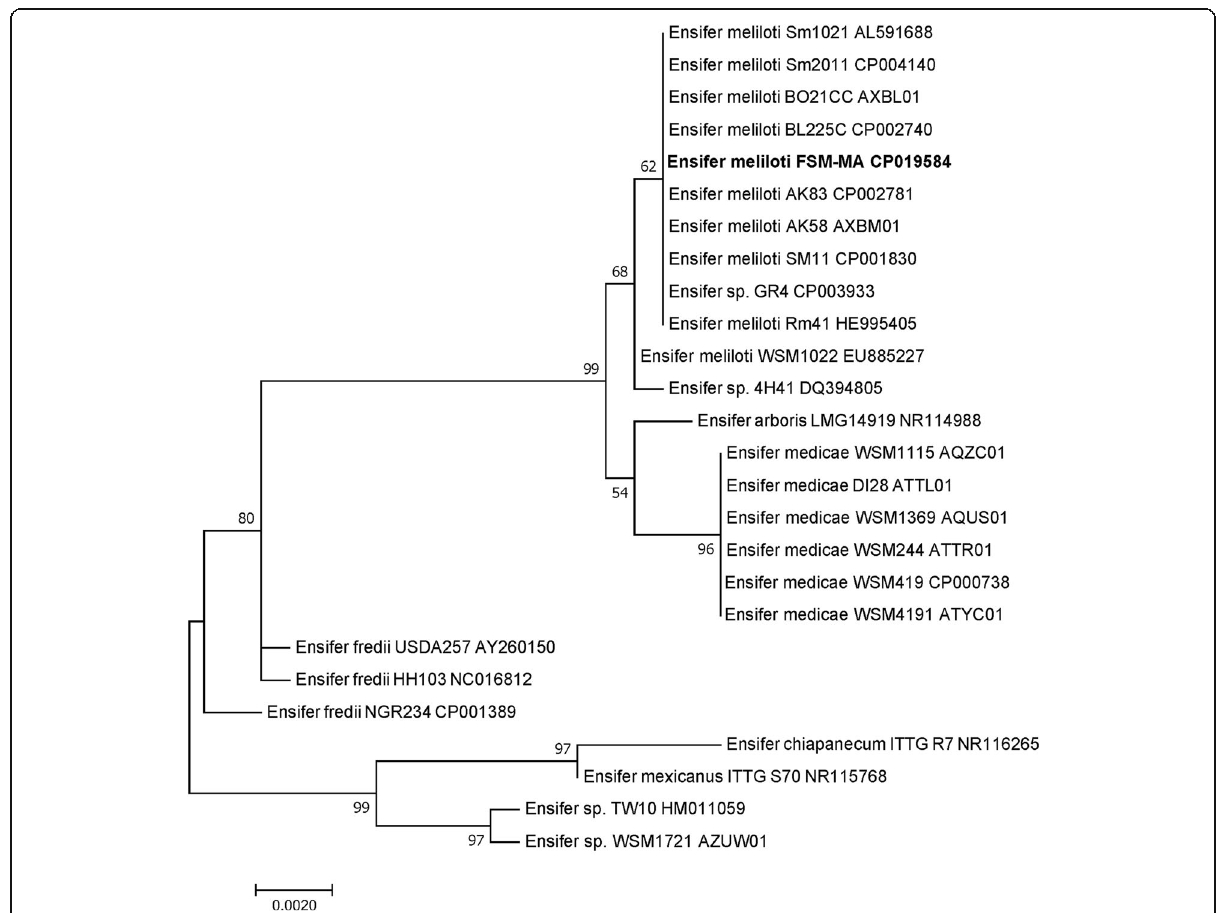
Fig. 2 Phylogenetic tree showing the relationship of E. meliloti strain FSM-MA. The evolutionary history was inferred by using the Maximum Likelihood method based on the General Time Reversible model [30]. The tree with the highest log likelihood ( − 2208.71) is shown. The percentage of trees in which the associated taxa clustered together is shown next to the branches. Initial tree(s) for the heuristic search were obtained automatically by applying Neighbor-Join and BioNJ algorithms to a matrix of pairwise distances estimated using the Maximum Composite Likelihood (MCL) approach, and then selecting the topology with superior log likelihood value. The tree is drawn to scale, with branch lengths measured in the number of substitutions per site. Evolutionary analyses were conducted in MEGA7